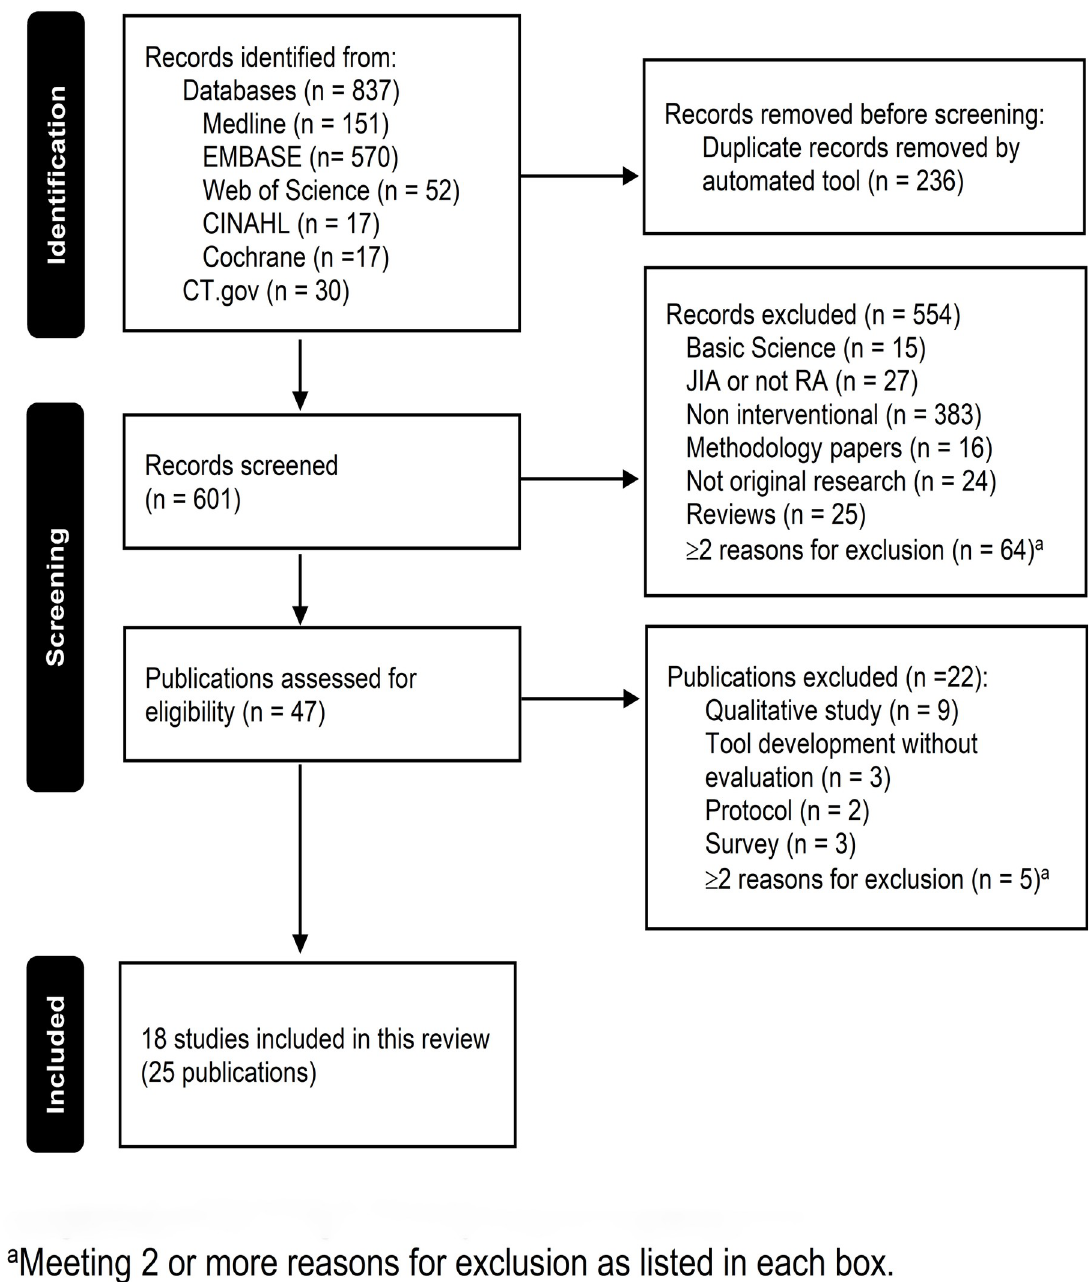
Fig 1. Diagram of study selection. CT.gov, ClinicalTrials.gov; JIA, juvenile idiopathic arthritis.